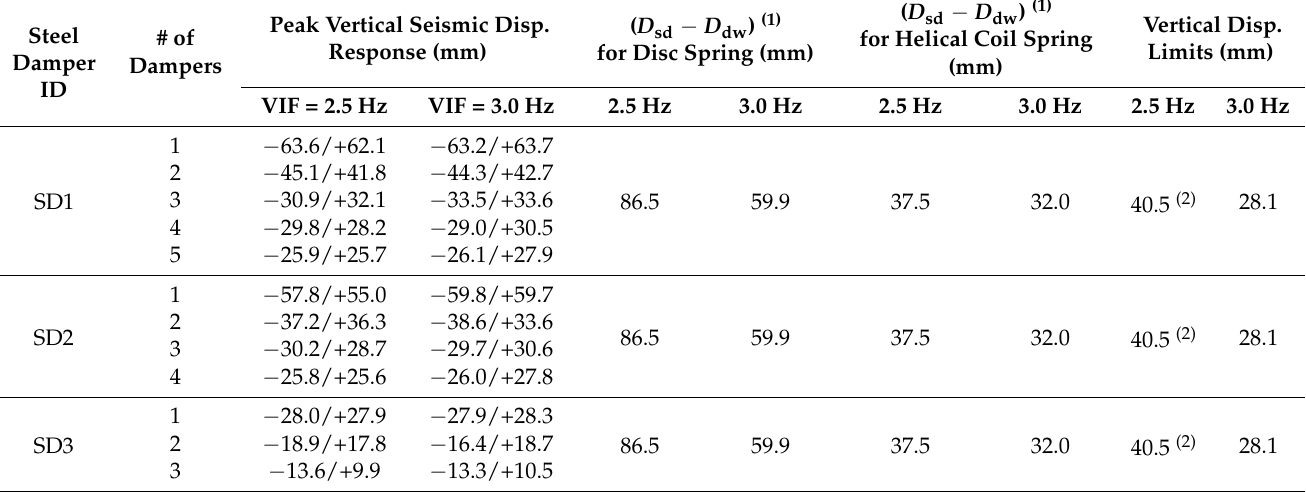
Table 13. Results of vertical seismic displacement responses of vertical isolation device.